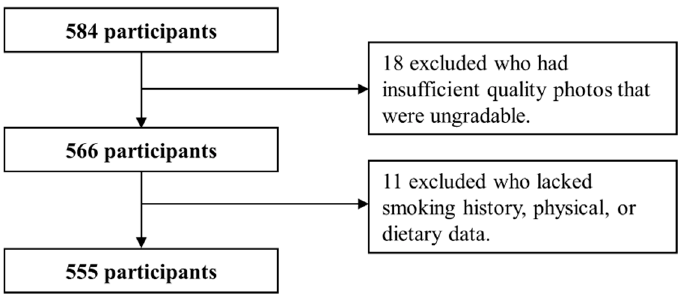
Figure 1. Flow chart demonstrating the identification of the study participants.